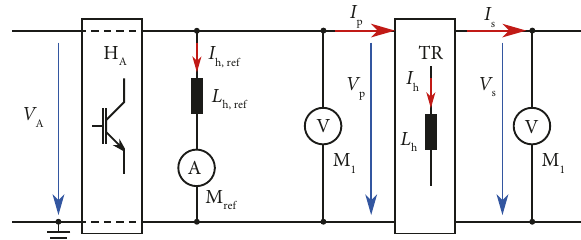
A and TR with for estimating I with observer. 1 h , DC serves as reference compared to ref